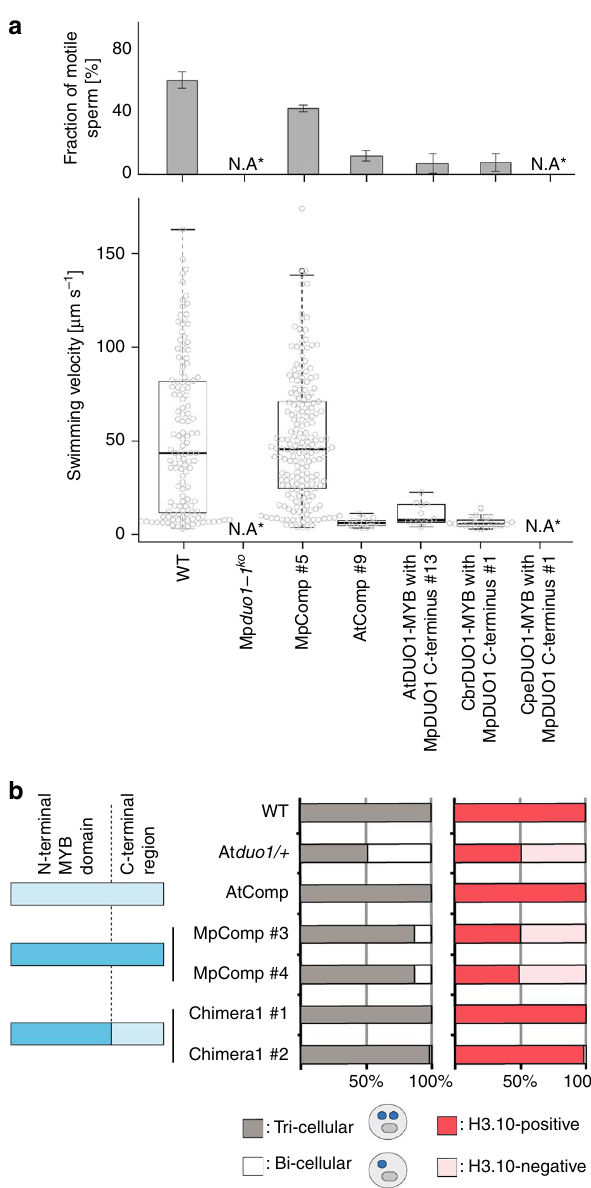
Supplementary Figs. 2, 5b). In Mp rkd-4 ge mutant, some sperm